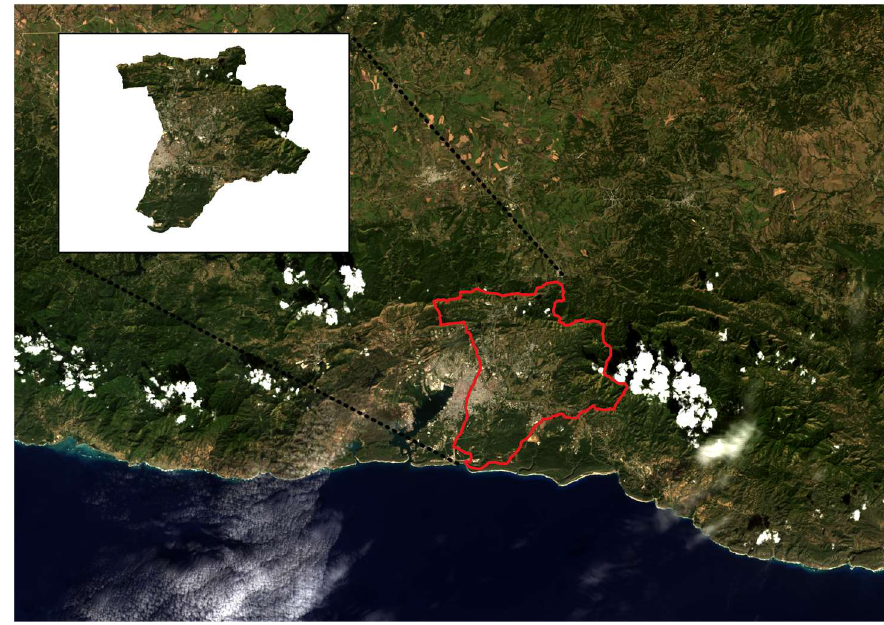
Figure 4. Landsat type images obtained of San Juan River Basin.